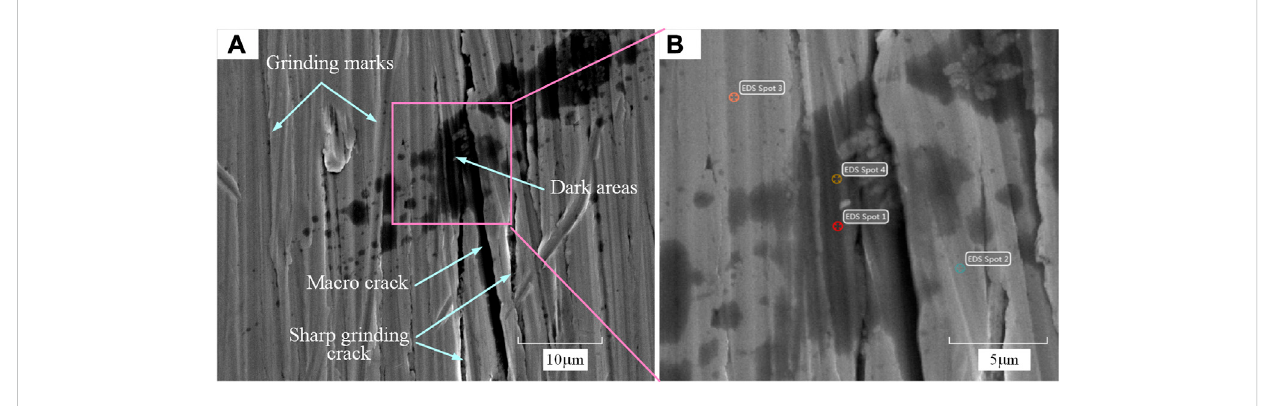
FIGURE 9 (A) Surface characteristics of the blade and (B) Schematic diagram of detection points.